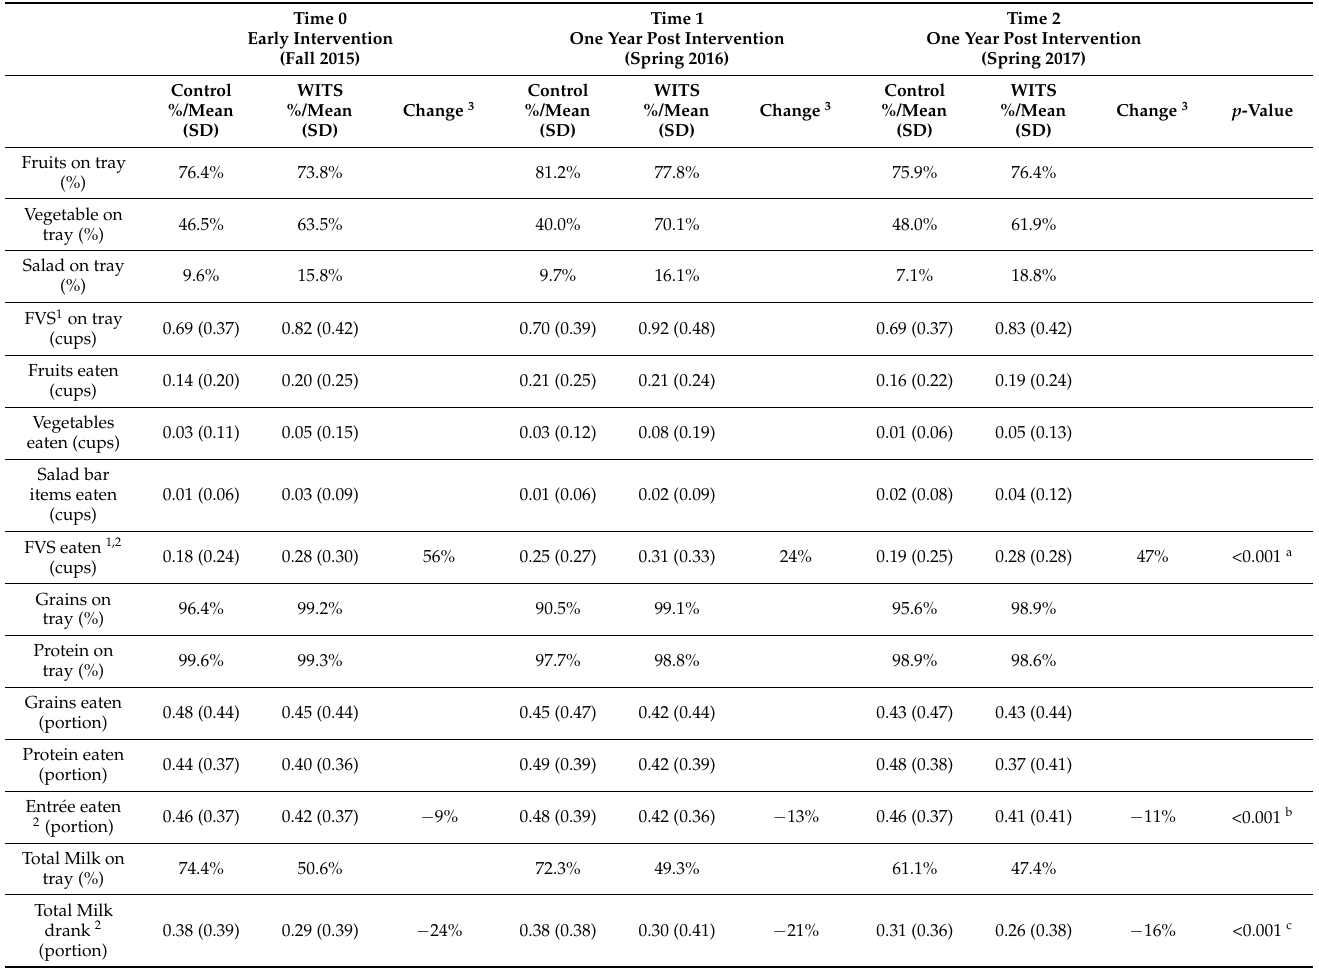
Table 2. School meal consumption: Control and Wellness in the Schools (WITS) intervention schools at Time 0, Time 1, and Time